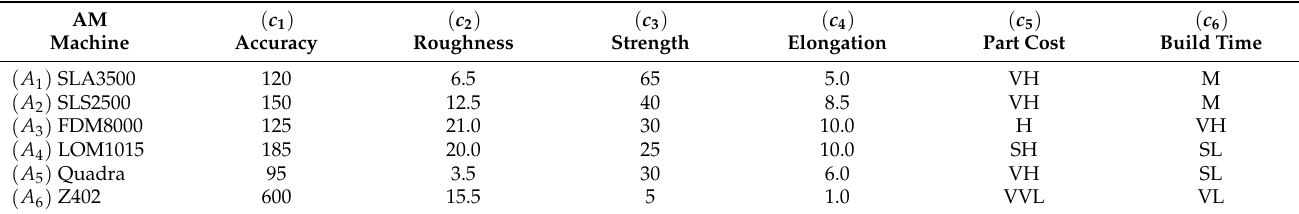
Table 7. Example 2 σ = ( 0.35, 0.4, 0.4, 0.4, 0.5, 0.4 ) .